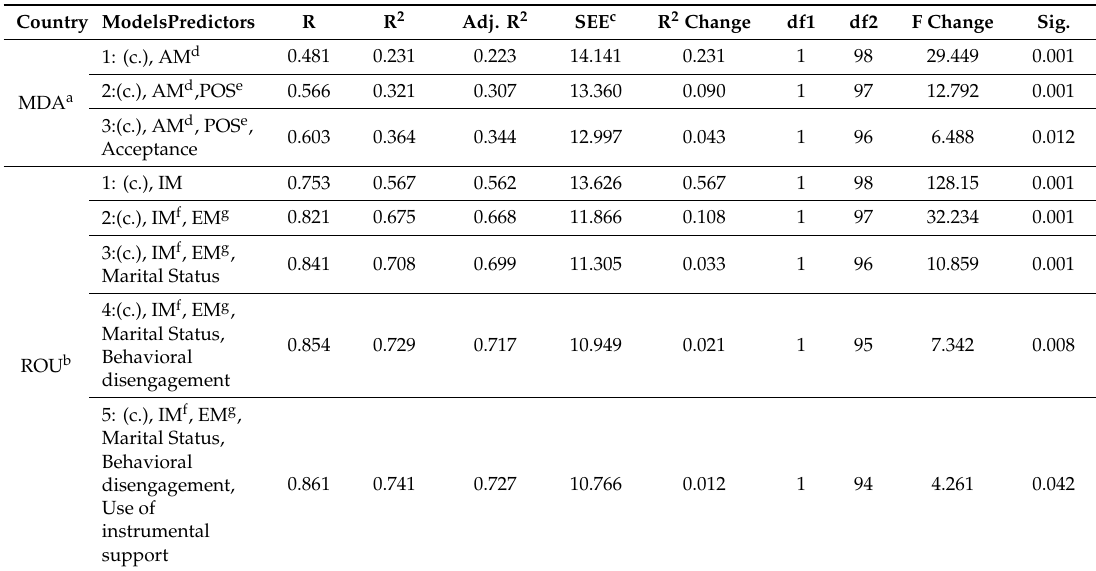
Table 6. Hierarchical linear regression models of global burnout in Moldova and Romania. Country